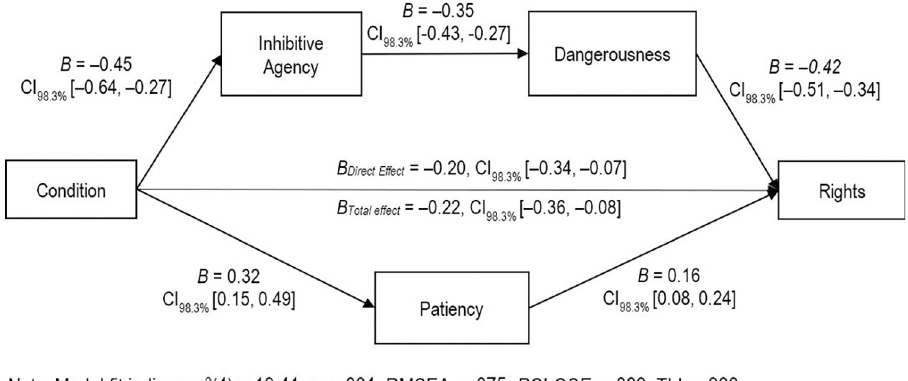
Fig 5. Dual path model of using the defense of mental impairment on rights as a citizen. Path values are expressed in unstandardized coefficients.